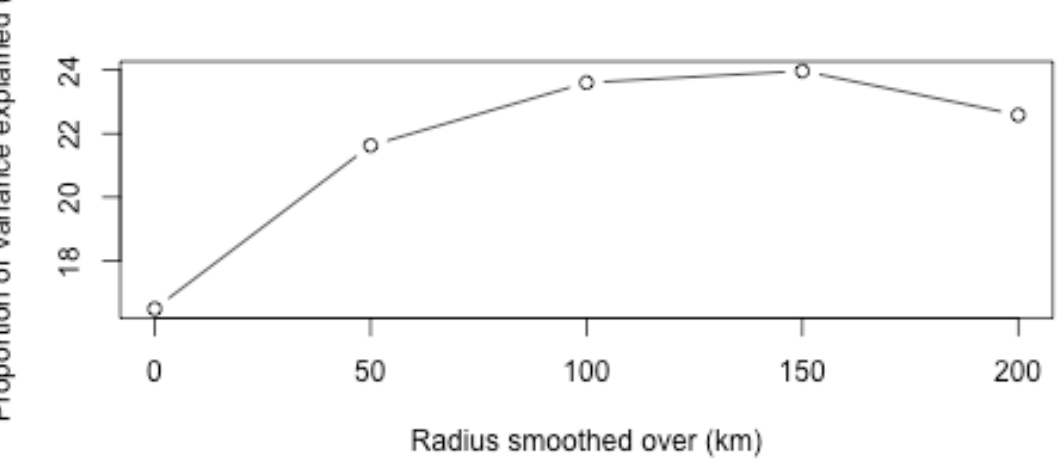
Figure 9. Box side length of region averaged over (smoothing radius), versus the percentage of variance in beta explained by total precipitation for January.